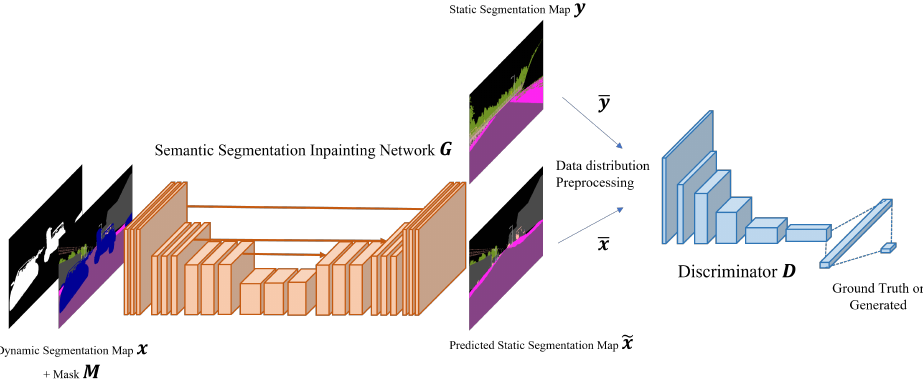
Figure 3. Overview of our architecture for the semantic segmentation inpainting network